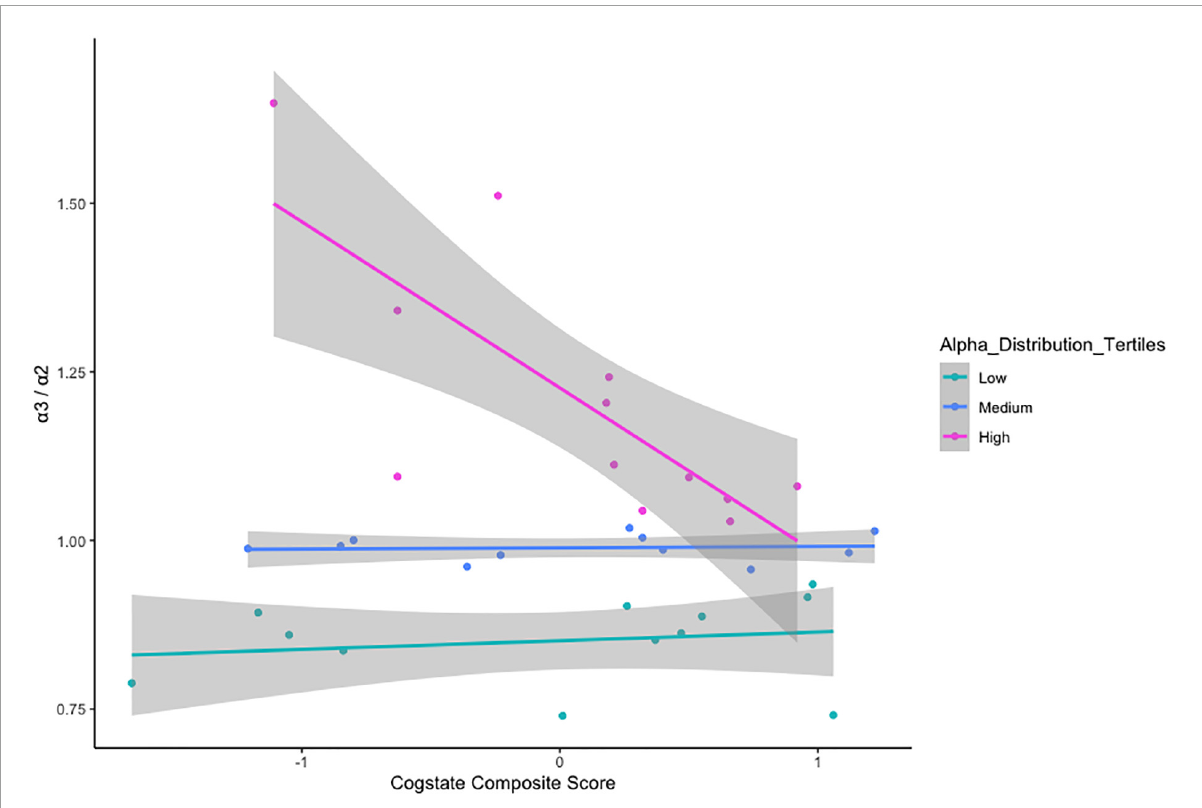
FIGURE6 Correlations between the Cogstate Composite Score and α 3/ α 2 ratios stratified by